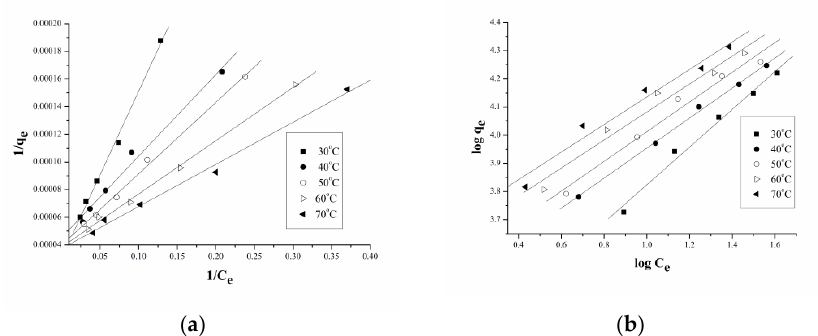
Figure 8. Plots for ( a ) Langmuir and ( b ) Freundlich isotherms at different temperatures . Table 5. Langmuir and Freundlich parameters for the adsorption of phenol . Table 5. Langmuir and Freundlich parameters for the adsorption of phenol. LANGMUIR PARAMETERS